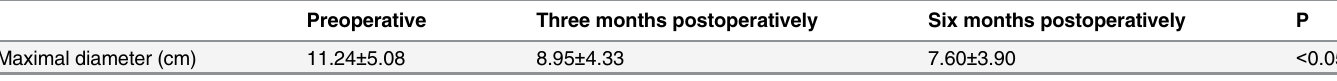
Table 2. Comparison of preoperative and postoperative maximum diameters of giant hepatic hemangiomas in 26